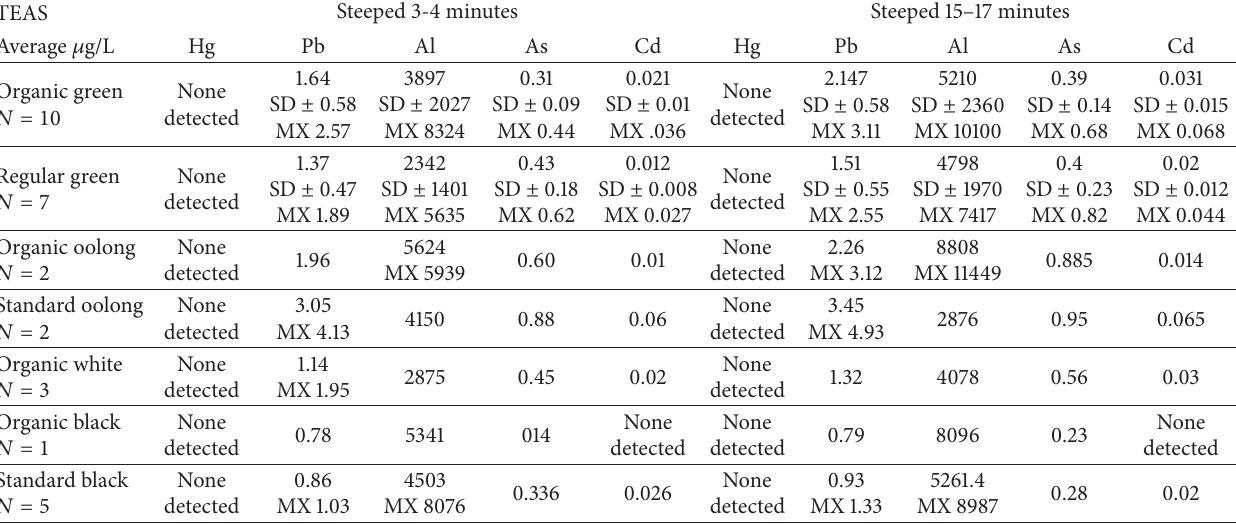
Table 3: Toxic element contaminants in